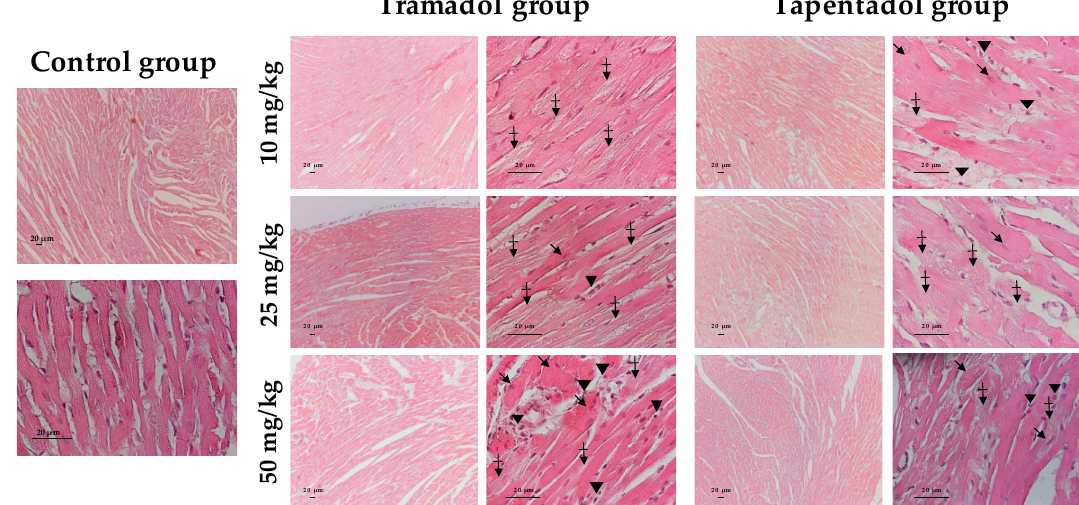
Figure 6. Photomicrographs of heart sections of Wistar rats intraperitoneally injected with different tramadol and tapentadol doses or saline (control group), for 14 consecutive days, upon hematoxylin and eosin (H & E) staining. A dotted staining (vertical, crossed arrows), possibly denoting fibrous tissue deposition, is observed among cardiomyocytes. Mononuclear inflammatory cells (inverted triangles) and altered cardiomyocytes (arrows), as well as loss of striation, are also observed. Photographs were taken with 100× and 600× magnifications. Scale bar, 20 μ m.